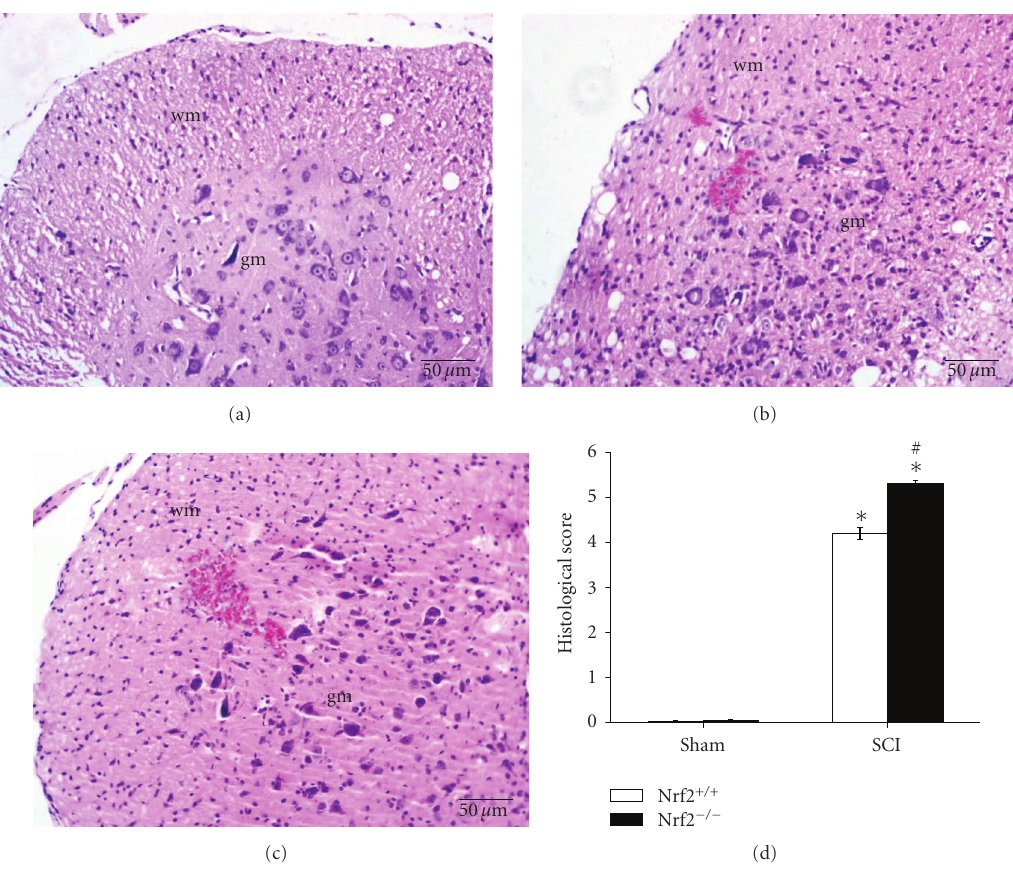
Figure 2: Influence of Nrf2 genotype on histological alterations of the spinal cord tissue 24 hours after SCI. No histologic alteration was observed in spinal cord tissues obtained from sham-operated mice (Figure 2(a)). A significant damage to the spinal cord from SCI mice at the perilesional, as assessed by the presence of edema as well as an alteration of the white matter (Figure 2(b)). Notably, the histological injury was severer in Nrf2 ( − / − ) mice (Figure 2(c)) than that in Nrf2 (+/+) mice (Figures 2(b) and 2(d)) at 24 hours after SCI. Bars represent mean ± S.E. ( n = 6, each group). ∗ P < . 01 versus genotype-matched sham-operated mice. # P < . 01 versus treatment-matched Nrf2 (+/+) mice. wm: white matter; gm: gray